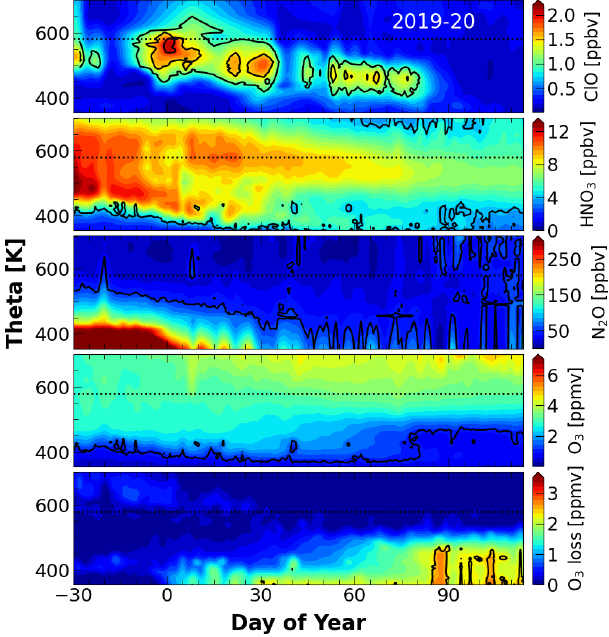
Figure 3. Ozone loss in the Arctic polar vortex in 2020. The distri- bution of ClO, HNO 3 , N 2 O and ozone (top to bottom) as measured by the Microwave Limb Sounder (MLS) for the Arctic winter of 2020. The bottom panel shows the ozone loss estimated using the MLS ozone by applying the tracer descent method (see Methods and Supplement). The vortex edge is computed in accordance with Nash et al. (1996) criterion. The vortex-sampled data are then aver- aged over each day and are